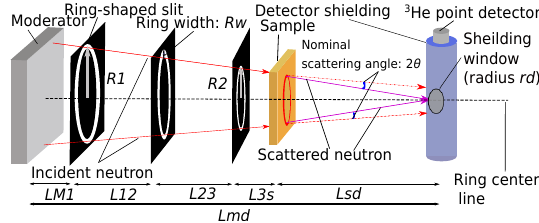
Fig. 1. Schematic diagram of r-SANS